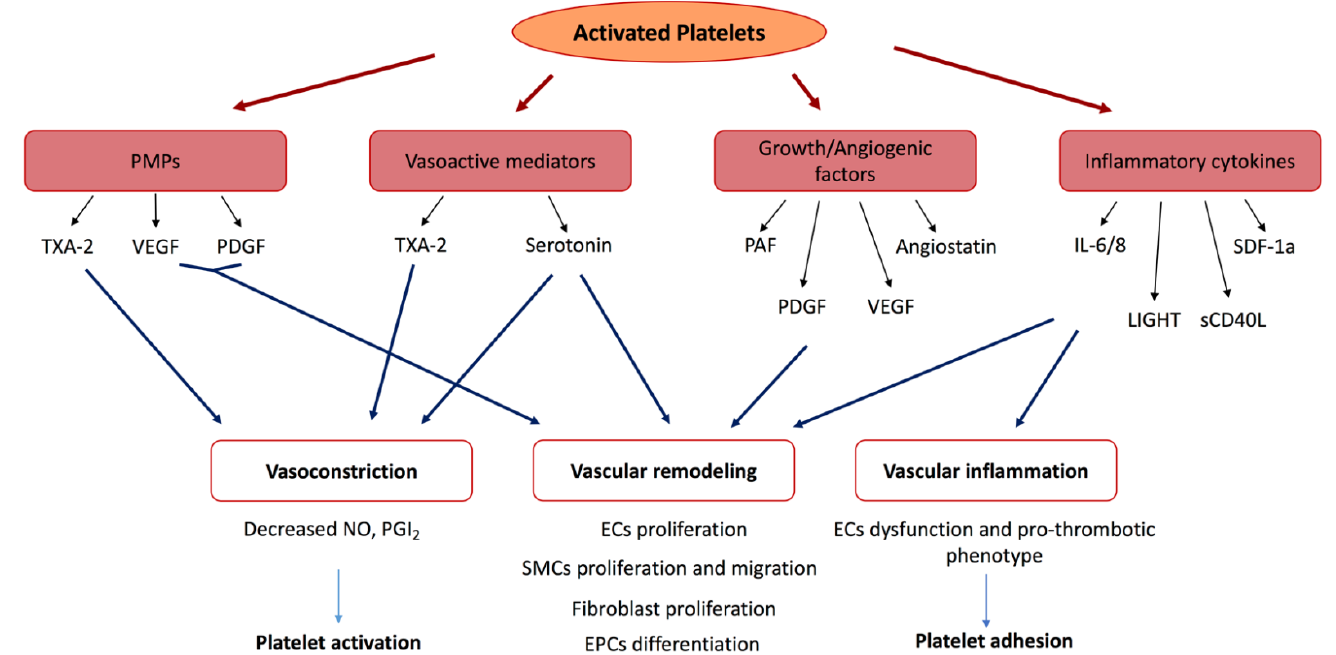
Figure 5. The contribution of platelet-derived factors to PH